Question: Draft a figure caption describing what is shown.
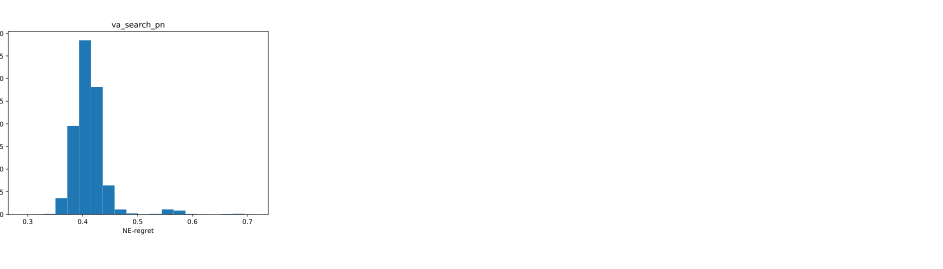
Answer: Empirical Distribution of NE-Regret of Barg(30, 0.125, 0.935)